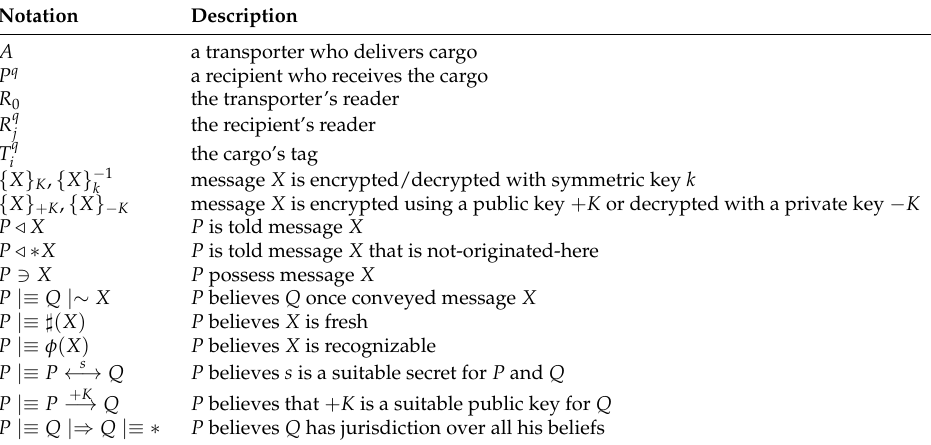
Table 7. Definition of GNY logic message.